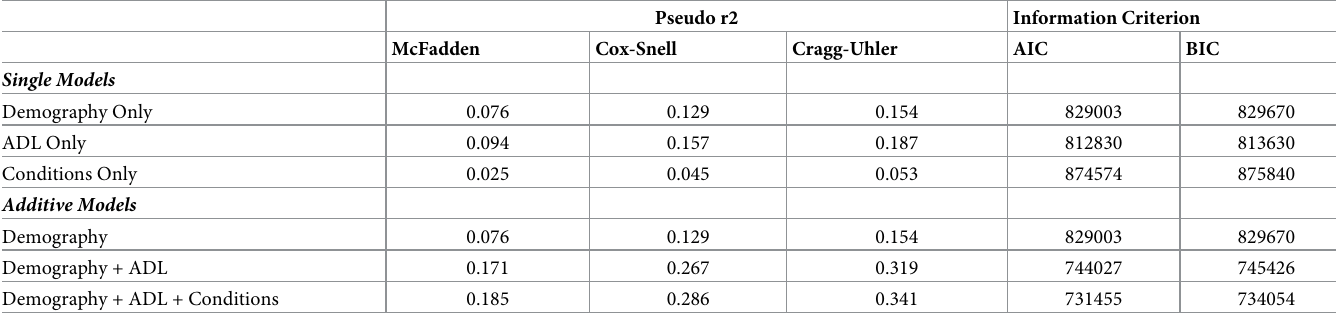
Table 6. Measures of fit, demography, assistance needs and